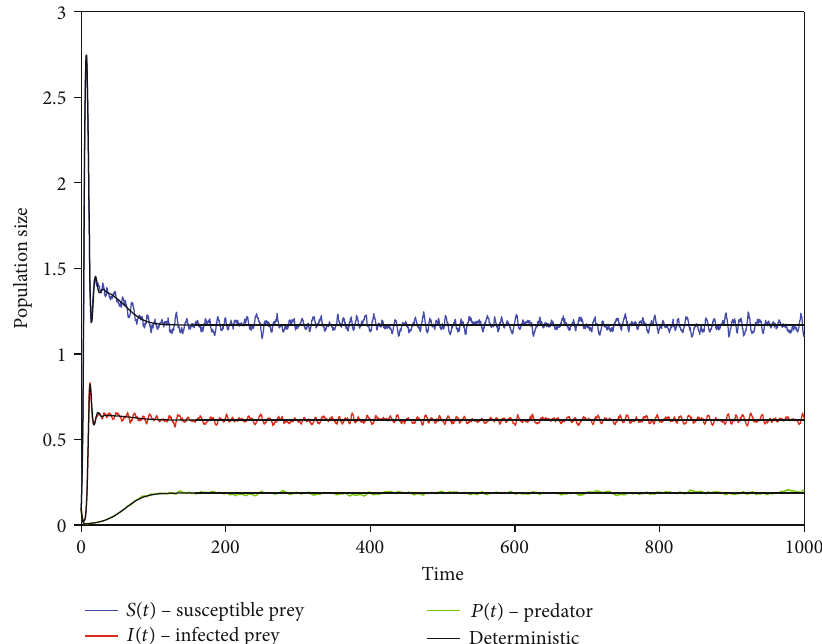
Figure 3: Simulation showing the solution curves of deterministic system (11) and corresponding stochastic system (23) with small noise σ = σ = σ = 0 : 01 1 2 3